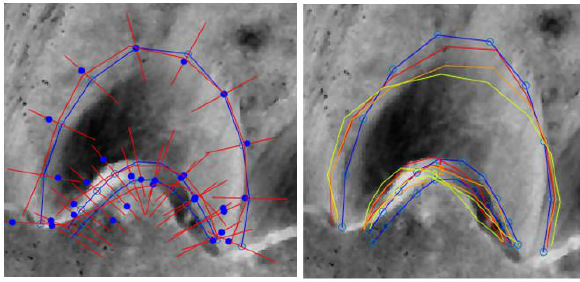
Figure 7: Left: Landmarks normal. Right: ASM